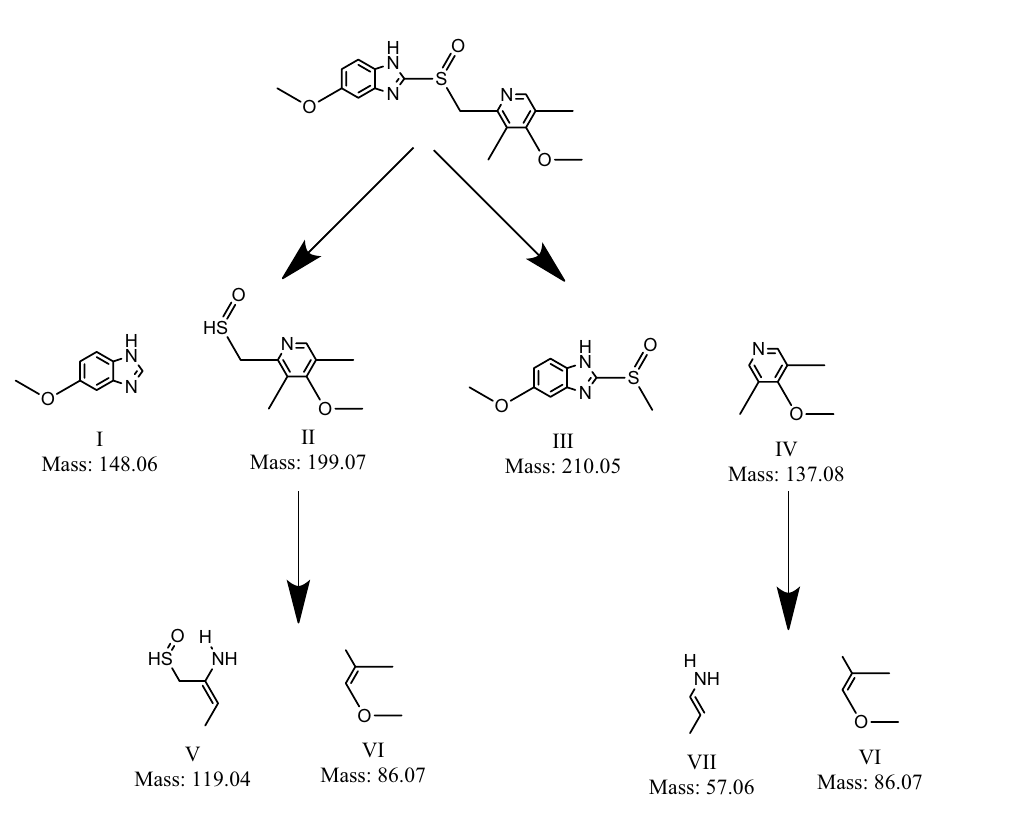
Figure 12. Schematic diagram of the plausible mechanism of